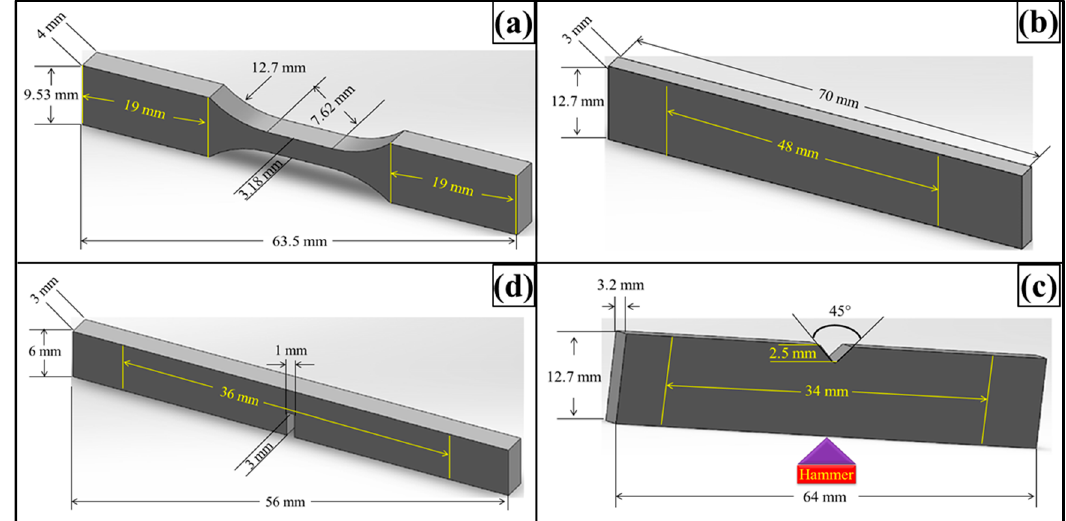
Figure 1. Schematics of mechanical test specimens: ( a ) Tensile; ( b ) Three point bend; ( c ) Charpy impact toughness; ( d ) Fracture toughness test specimens.